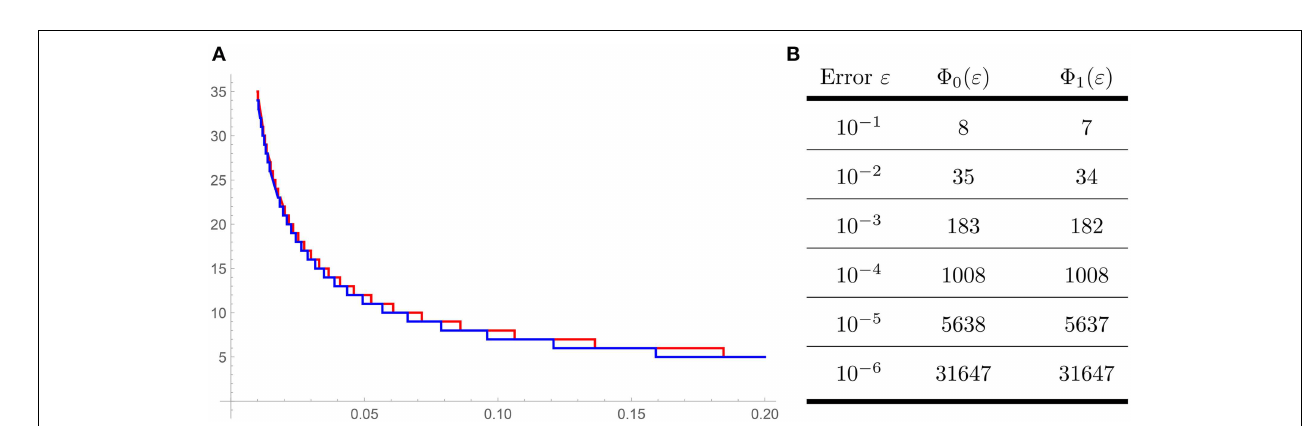
FIGURE 1 | (A) Red line is the ratio taking as a starting point u 1 corresponds to u 1